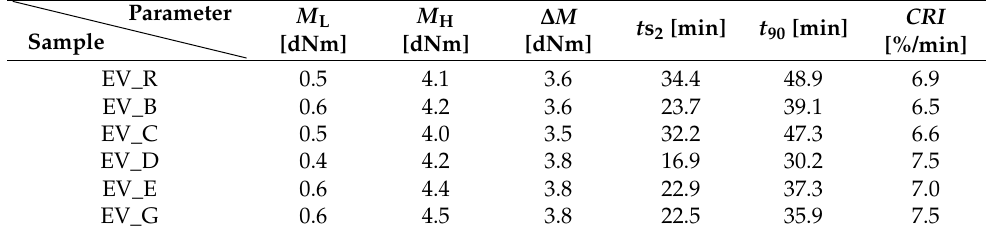
Table 8. Parameters for the vulcanization of rubber compounds prepared in the EV system.